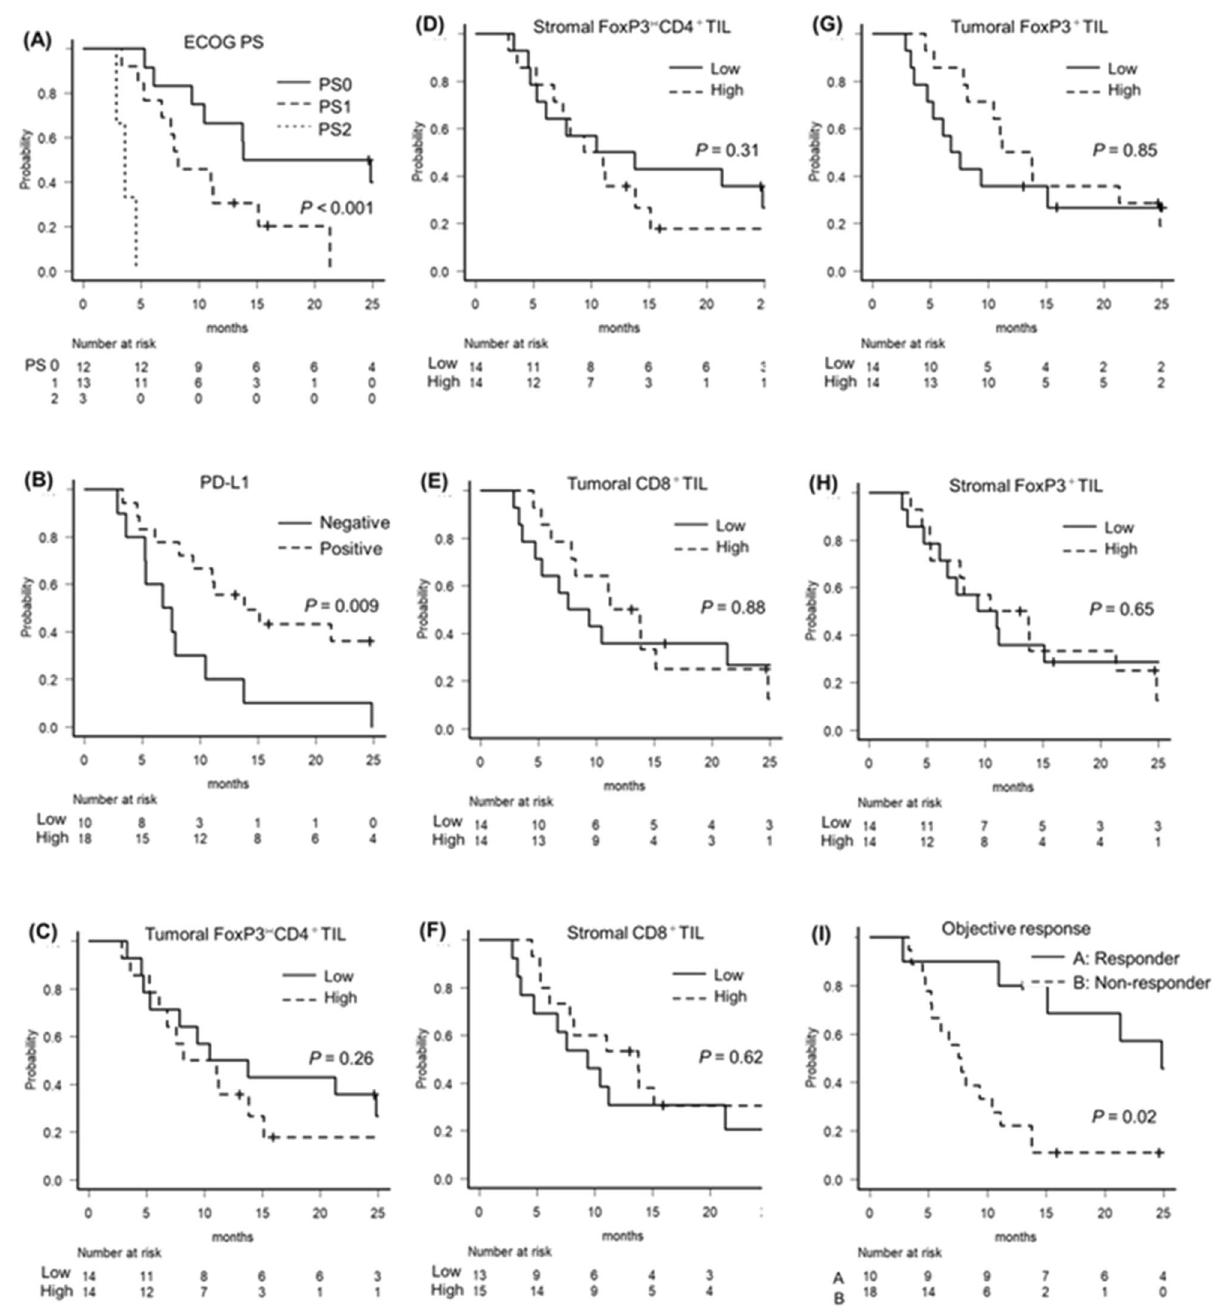
Figure 3. Kaplan–Meier curves for OS of each type. ( A ) Survival curve of ECOG PS. ( B ) PD-L1. ( C ) tumoral FoxP3 − CD4 + TIL. ( D ) stromal FoxP3 − CD4 + TIL. ( E ) tumoral CD8 + TIL. ( F ) stromal CD8 + TIL. ( G ) tumoral FoxP3 + TIL. ( H ) stromal FoxP3 + TIL. ( I ) Objective